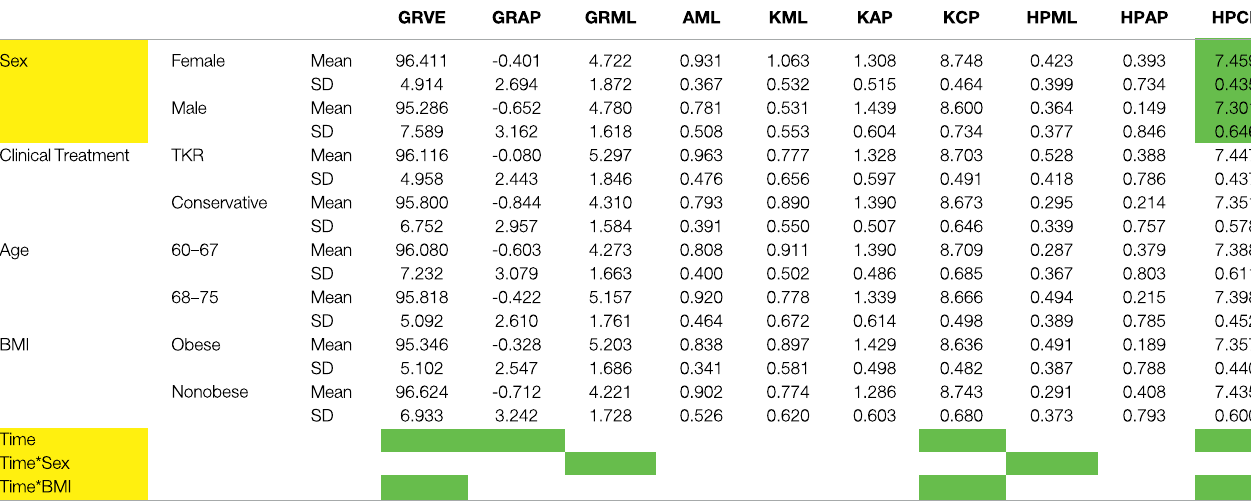
TABLE 5 | Forces means and standard deviation. Yellow color indicates signi fi cant multivariate effect ( p < 0.018). Green color indicates signi fi cant univariate effect. ( p < 0.005). Vertical(VE),Anterior-Posterior (AP)and Medio-Lateral(ML) ground reaction (GR)forces,respectivelyGRVE,GRAPand GRML.Joints forces werecomputed